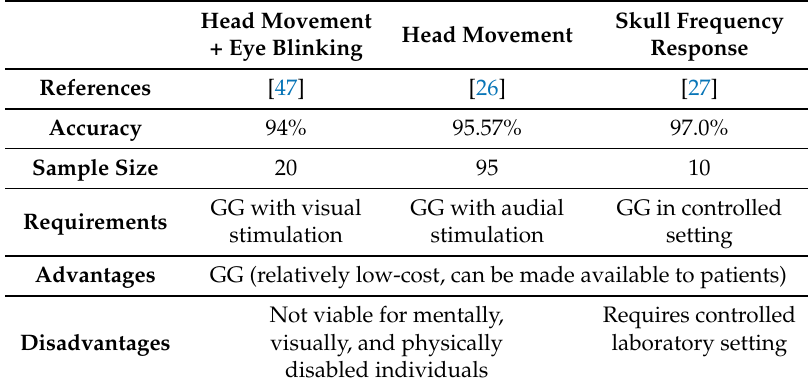
Table 4. Head Wearable Device Evaluation by